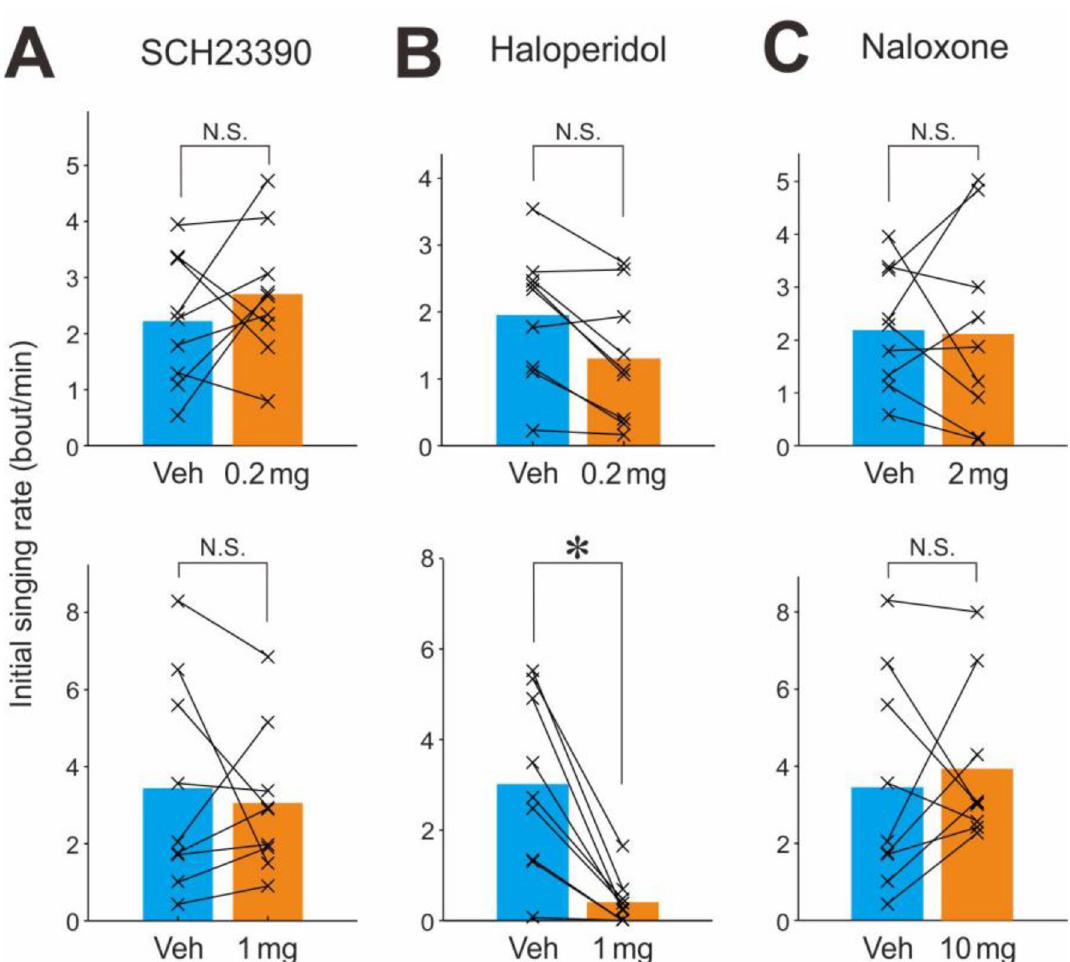
Figure 6. Effects of systemic injections of dopamine or opioid antagonists on initial singing rates after 5-h LO in young adult birds. Conventions are same as in Fig. 5. Only the higher dose (1 mg/kg) of haloperidol significantly decreased initial singing rates (* p = 0.004 and corrected α =